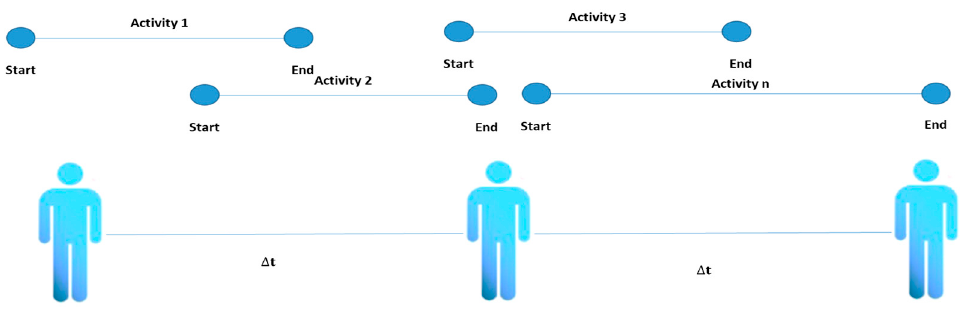
Figure 2. Single activity representation.